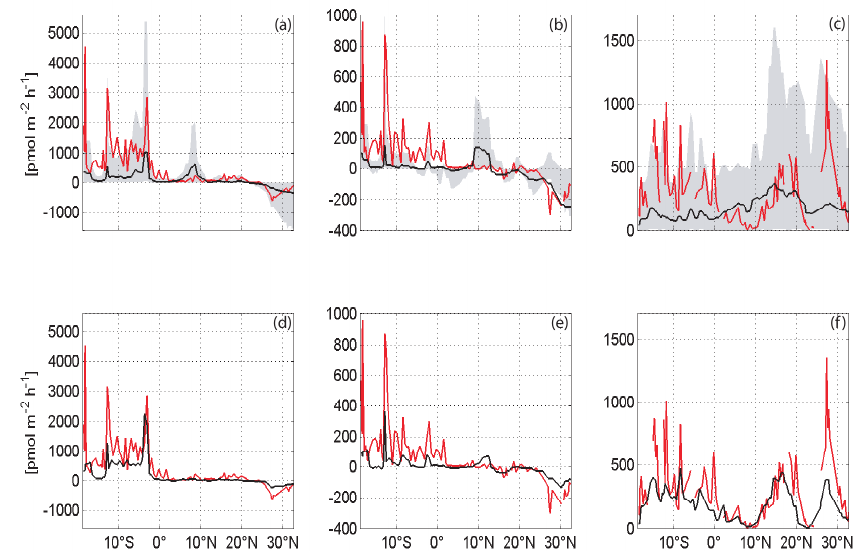
Fig. 9. The upper panels illustrate the comparison between our climatological estimate (black line) and the in situ sea-to-air fluxes from the TransBrom cruise (red line) for bromoform (a) , dibromomethane (b) and methyl iodide (c) inpmolm − 2 h − 1 (see more details in the text) including the climatological minimum and maximum values (grey shaded area). The lower panels represent the same in situ measurements compared to our model values using the nearest 6-hourly mean of SST, U and SLP and monthly mean of SSS with fixed mixing ratios and oceanic concentrations calculated with the RF method for bromoform (d) , dibromomethane (e) and methyl iodide (f) (the emissions using OLS look